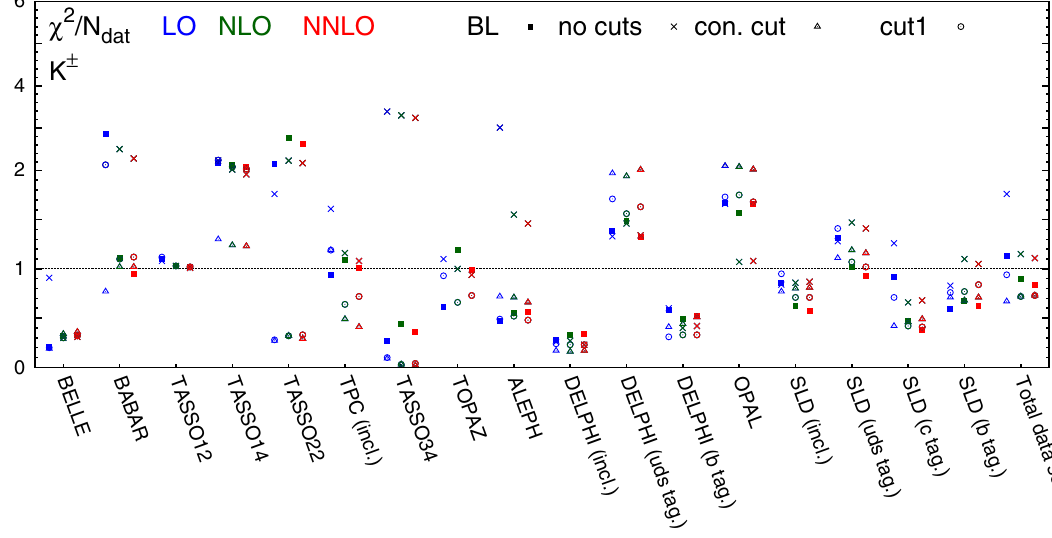
z min = 0 . 02 with the same accuracy as a small- z resummed NNLO+NNLL fit. Third, at any perturbative order, the χ 2 / N dat of the fit with baseline kinematic cuts is always very close to the lowest χ 2 / N dat , usually associated to the fit with conservative cuts. The only exception is the proton/antiproton case, where the fit with the baseline cuts has a χ 2 / N dat significantly larger than the fit with conservative cuts. This behaviour is mostly driven by the high value of the χ 2 / N dat for the BABAR data. However, as already mentioned in Sect. 5.1, this is due to a genuine tension between the BABAR and